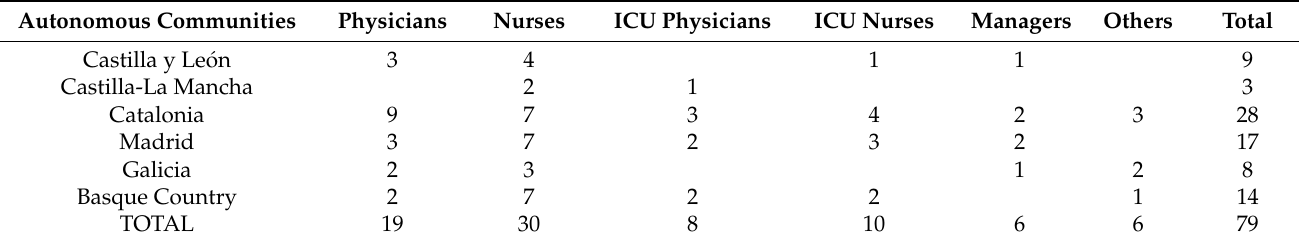
Table 1. Territorial and professional distribution of the participants in the